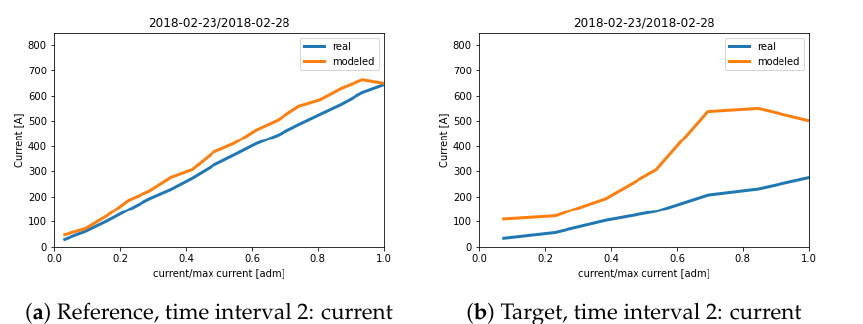
Figure 5. Measured and simulated current for the reference (Ref) and the target (Tar) wind turbines: data set D fault